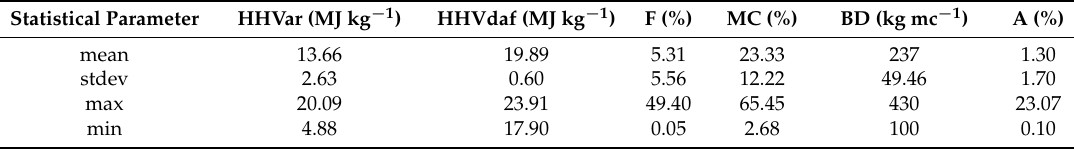
Table 3. Descriptive statistics of quality parameters (HHVar: High Heating Value as received; HHVdaf: High Heating Value dry basis ash free; Fines: F; Moisture Content: MC; Bulk Density: BD; Ash on dry basis: